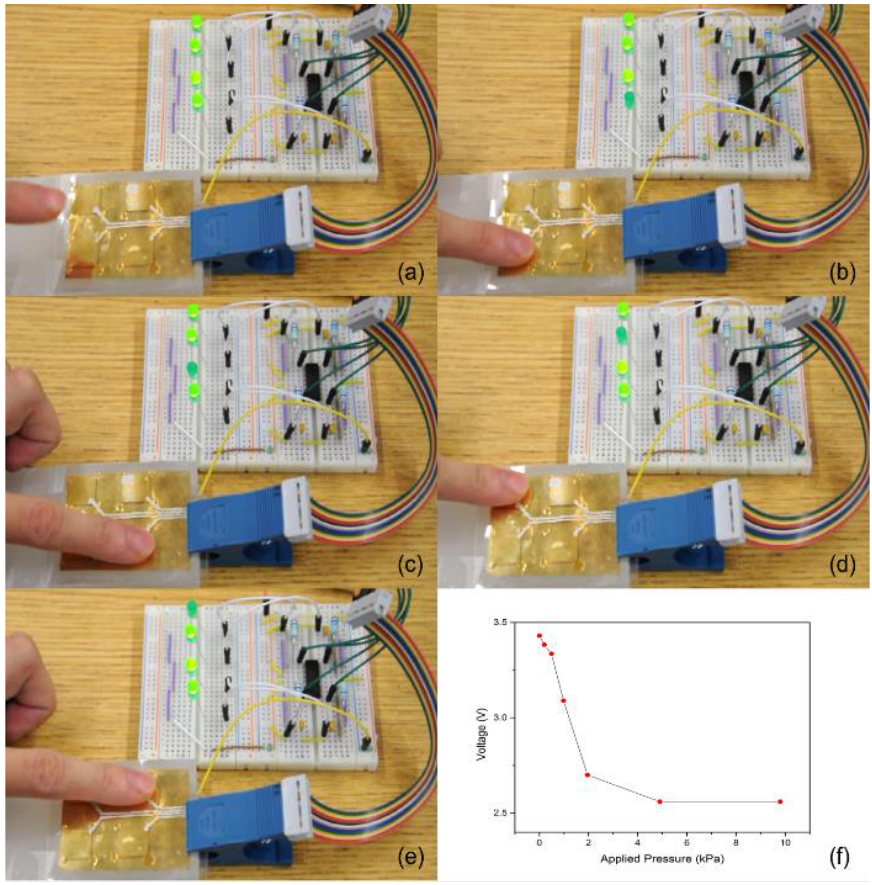
Figure 10. ( a – e ) Pressure sensing result ( f ) Pressure – voltage relationship of the testing piezoelectret.